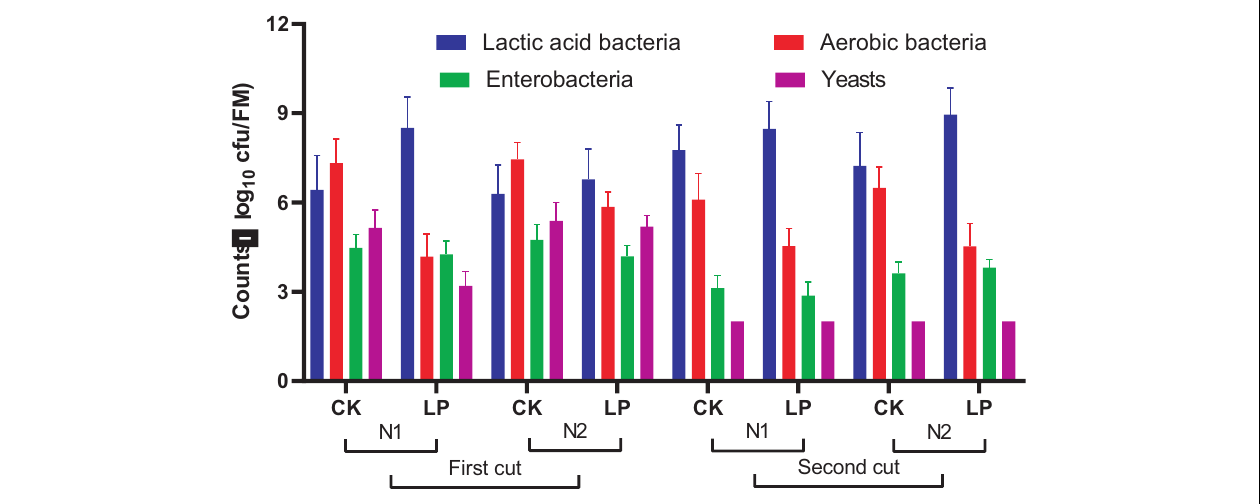
FIGURE 1 | Microbial population of silage treated without (CK) or with Lactobacillus plantarum (LP). Application of N fertilizations during cultivation was N1 (390 kg/ha/year) and N2 (485 kg/ha/year). Bar in each column represented standard error of mean.